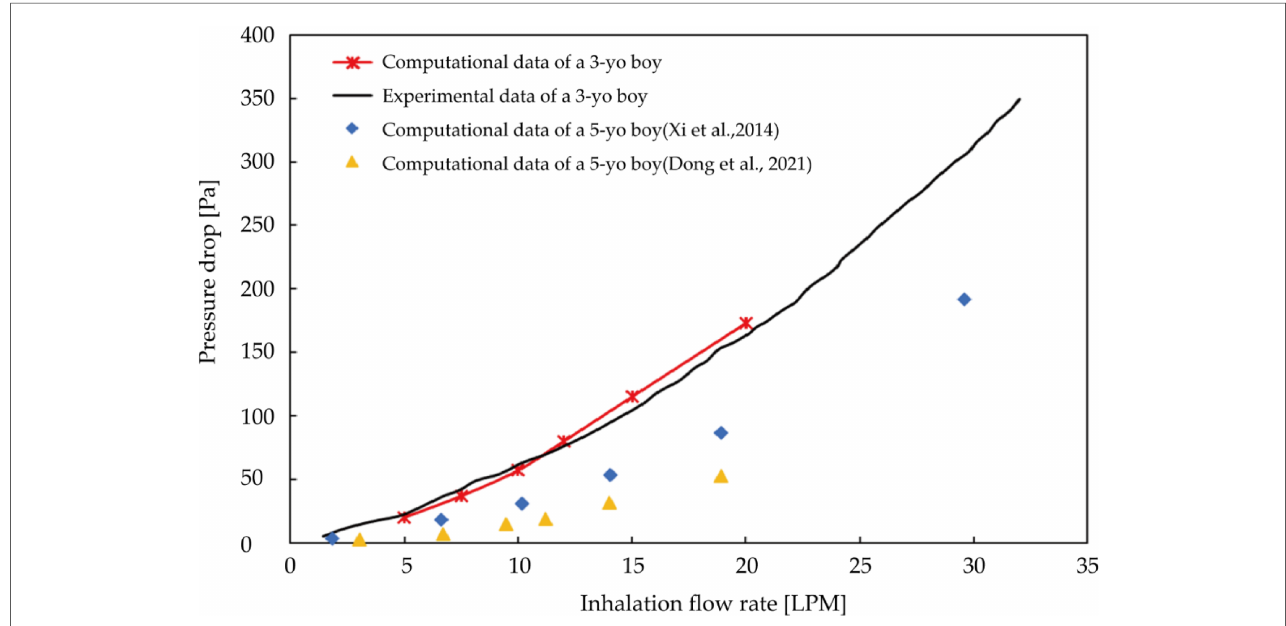
FIGURE 4 Measurement and numerical predicted trans-nasal pressure- fl ow curves with comparison data from previous